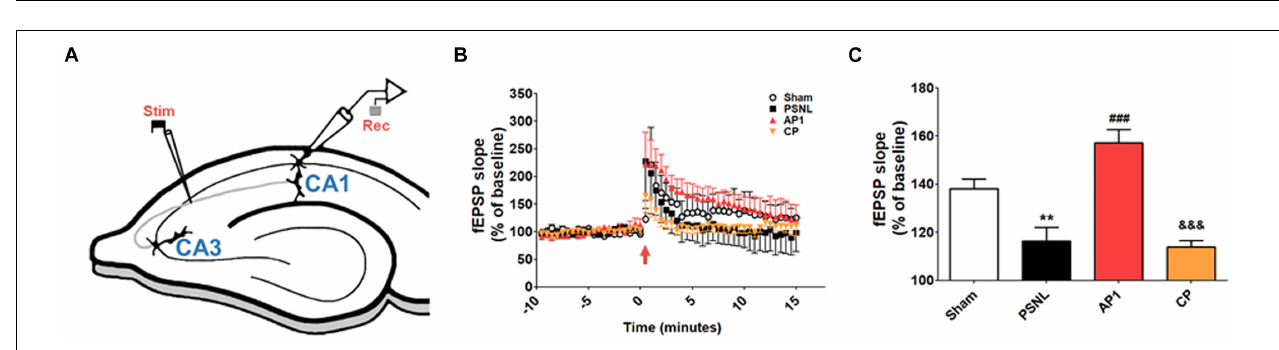
FIGURE 3 | Effects of acupuncture on classification using a random forest classifier analysis in machine learning method. Cognitive functions and nociceptive behavior data of the four groups (Sham, PSNL, AP1, and CP) were analyzed by random forest algorithm in machine learning. Representative figures show that the spontaneous alternation in Y-maze (A) and recognition index in NOR test (B) were analyzed against the paw withdrawal frequency in the von Frey test. All groups: n = 10. AP1, acupuncture 1 (GB30 and GB34); CP, control point.